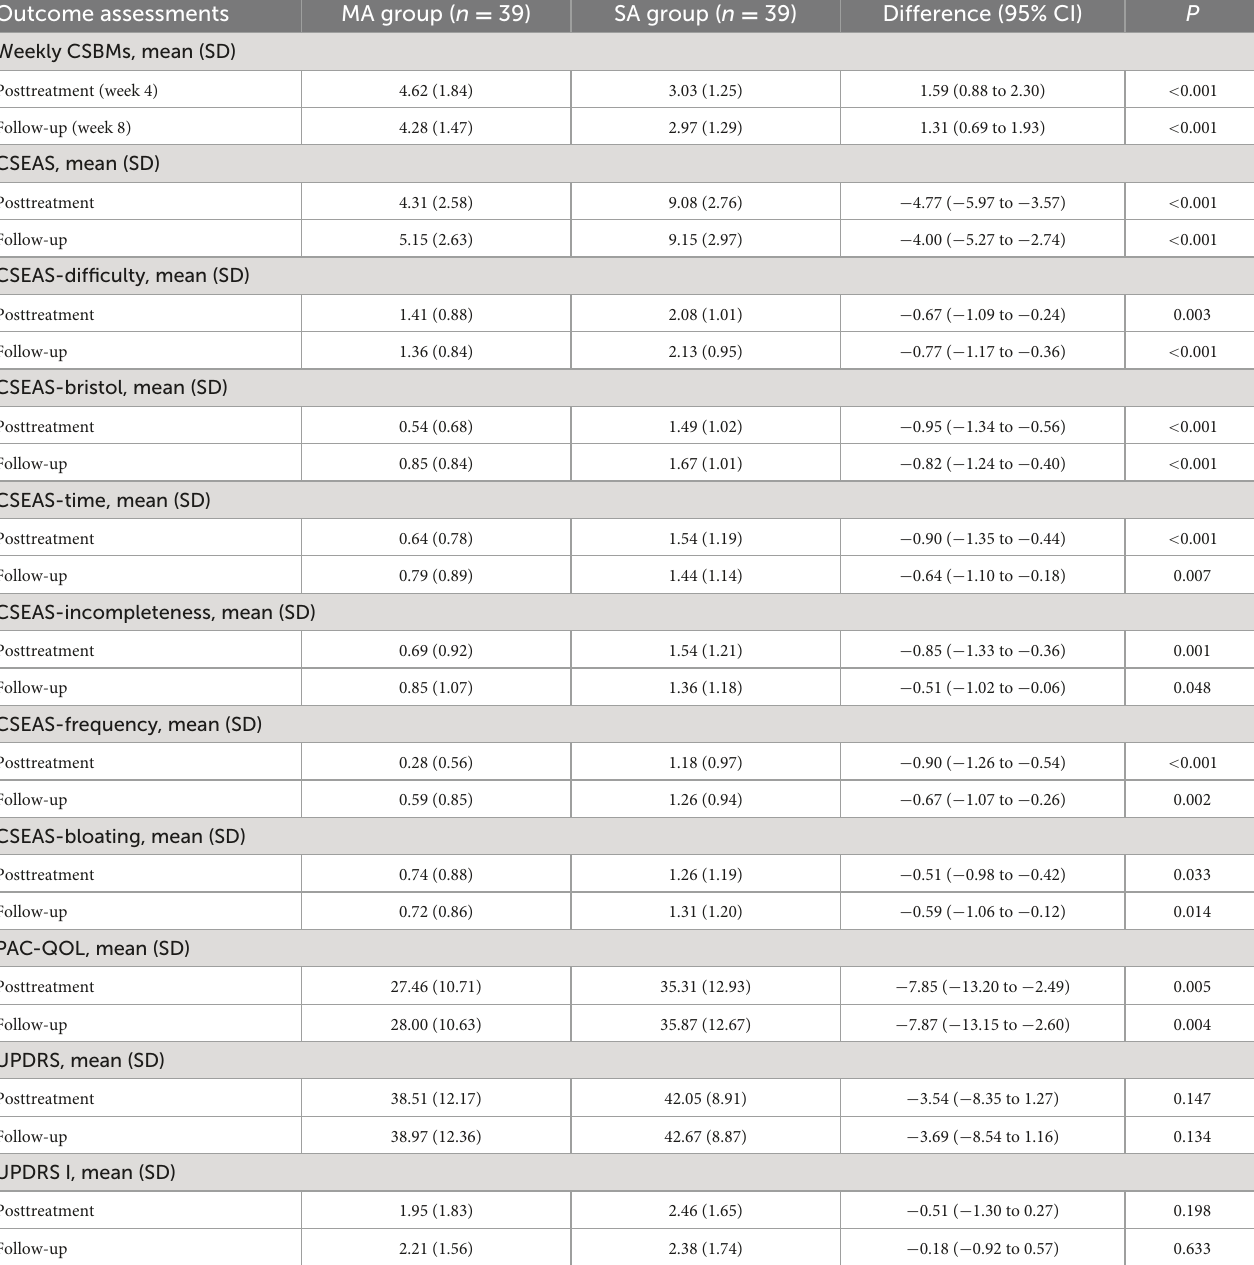
TABLE 2 Comparison of the primary and secondary outcomes in the manual acupuncture (MA) and sham acupuncture (SA) groups. Outcome